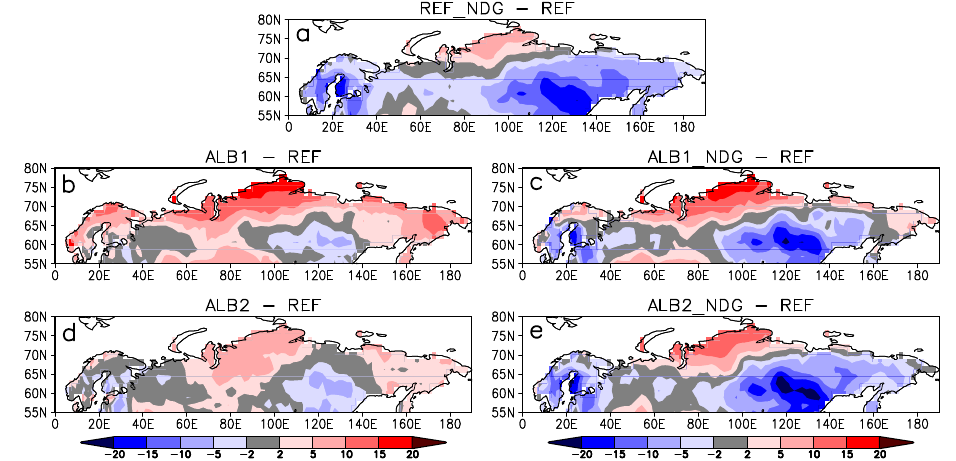
Figure 9. Differences in average snow-off date between the five sensitivity experiments (REF_NDG, ALB1, ALB1_NDG, ALB2 and ALB2_NDG) and the REF experiment.